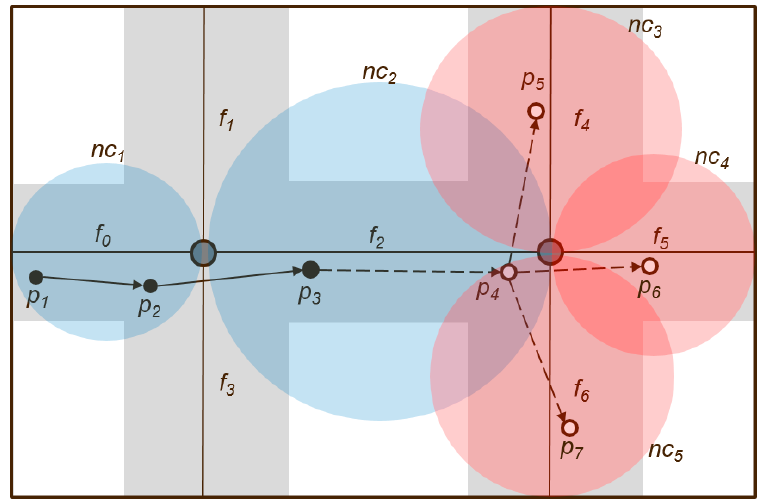
Figure 6. Graphical representation of applying path prediction.